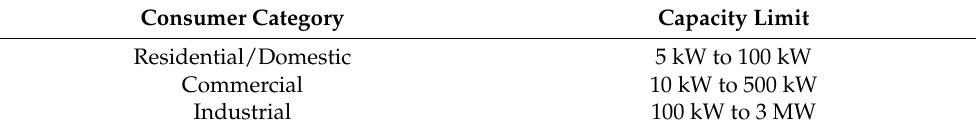
Table 6. Installed capacity limits of NEM consumers [75].